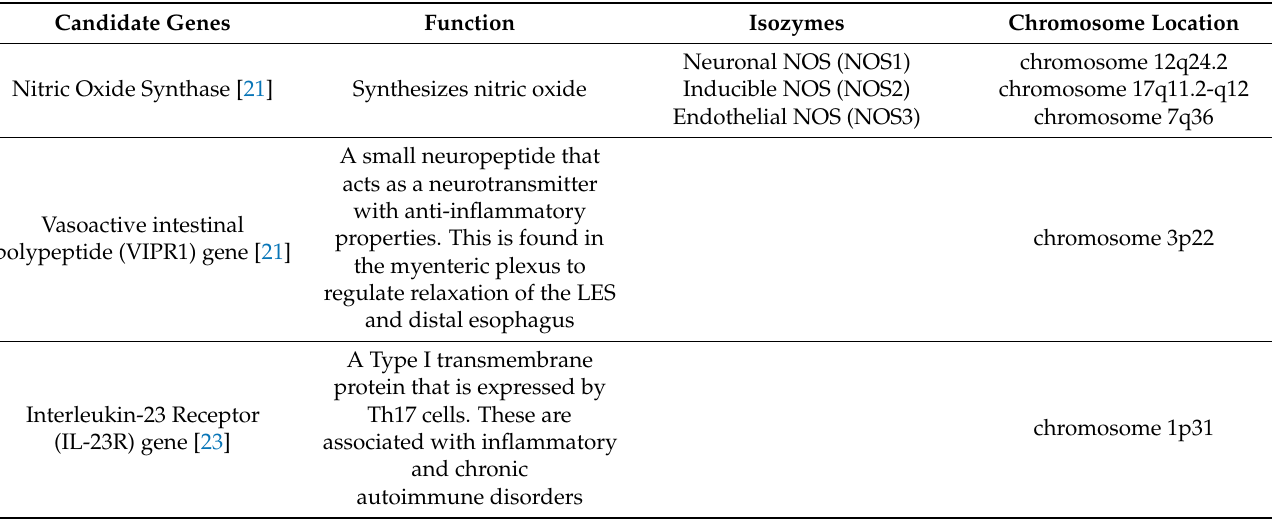
Table 4. Description of prominent candidate genes that may be increase one’s susceptibly to idio- pathic